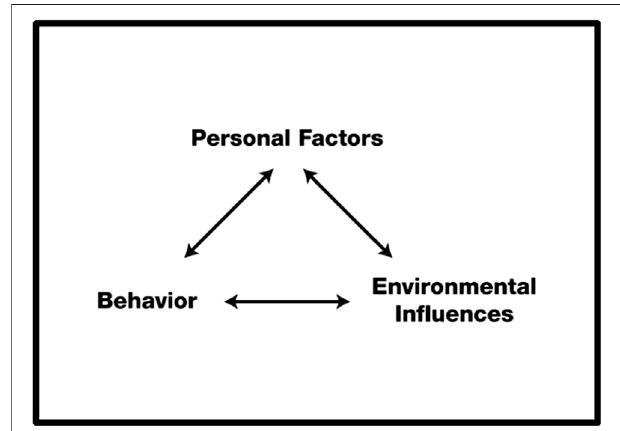
FIGURE 1 | Bandura ’ s (1986) model of triadic reciprocal